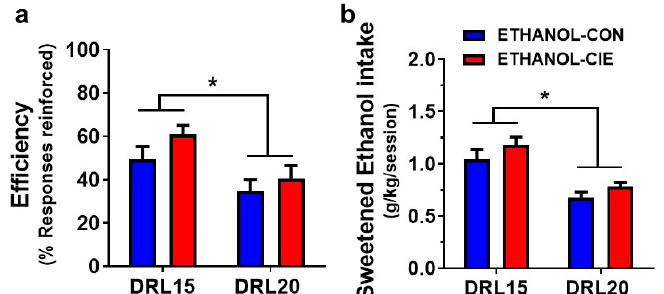
Figure 6. Efficiency of reinforcement and reinforcer intake decreased during an unexpected DRL20 schedule compared with under the DRL15 schedule in ethanol animals. No differences were found between the ETHANOL-CIE group (red) and ETHANOL-CON group (blue) in ( a ) the efficiency of ethanol reinforcement or ( b ) the number of sucrose reinforcers earned. The data are expressed as the mean ± SEM for percent reinforcers earned/responses emitted. n = 7–8/group. * p < 0.05, compared with corresponding values during the DRL20 challenge.